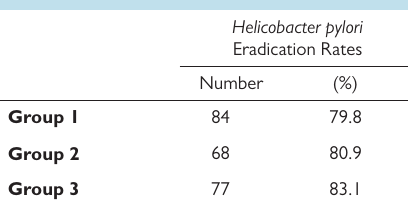
Table 4. Helicobacter pylori Treatment Eradication Achievement